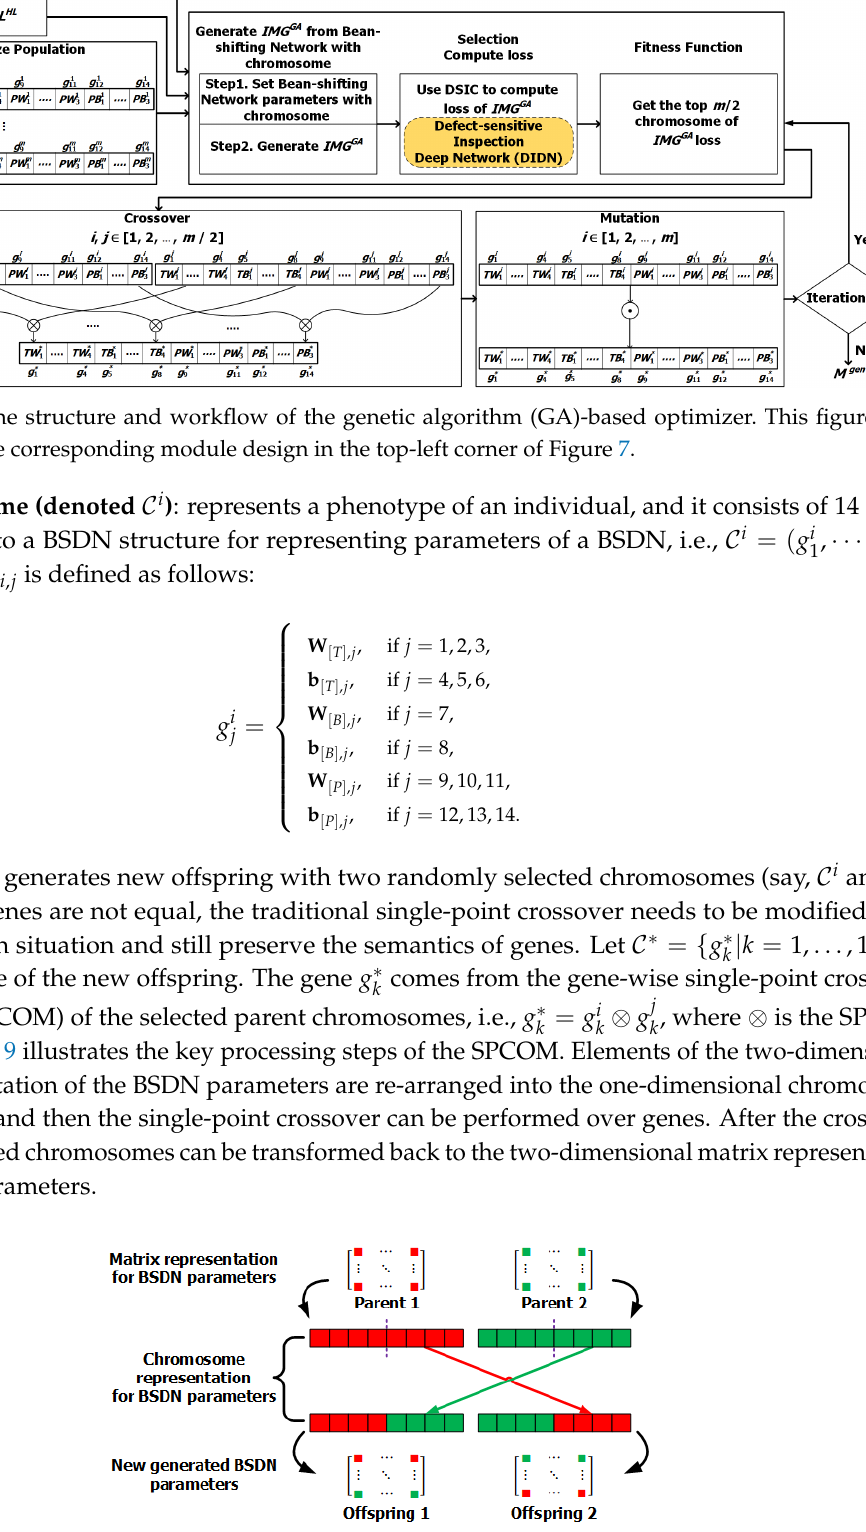
Figure 9. The gene-wise single-point crossover over matrix of the selected parent